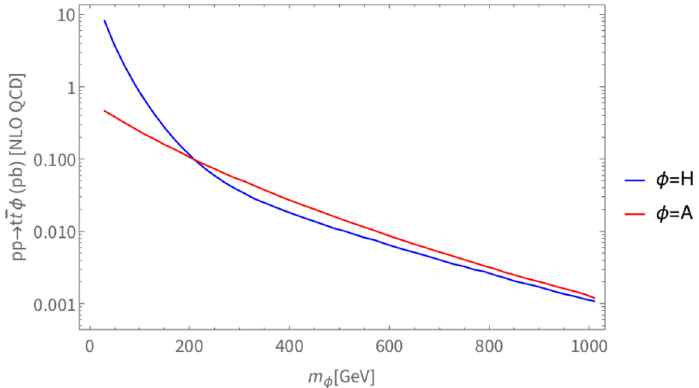
Figure 3. Total cross section for the process pp ! t (cid:22) tH (blue) and pp ! t (cid:22) tA (red) as a function of the (cid:30) boson mass, at NLO, for a centre-of-mass energy of 13 TeV, at the LHC. Details about the generation of the events represented through (cid:12)gures 3, 4, 5 and 6, can be found in section 3.1. pp ! b (cid:22) b(cid:30) for m = 125 GeV. In blue, we present the pure scalar case while in red (cid:30)